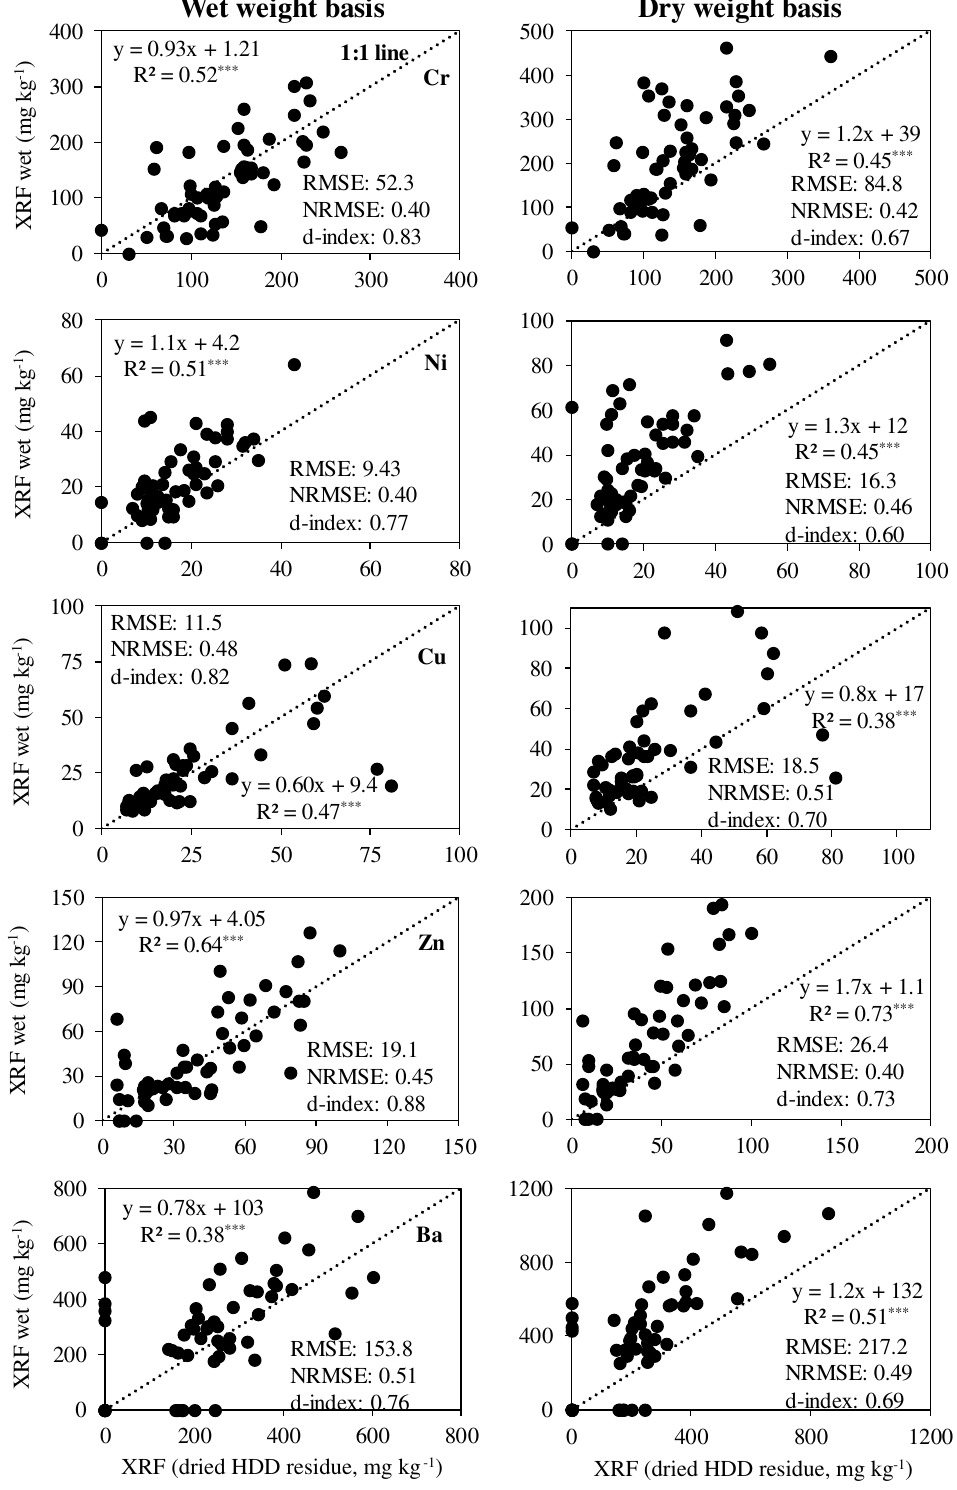
Figure 4. Linear regressions and statistical parameters between metal concentrations determined by pXRF on oven-dried and moist (wet) samples after removing excess water from 59 horizontal directional drilling (HDD) residues collected from 26 states of the US (a few outliers were removed under the normality assumption). ***: P < 0.001. **: P <